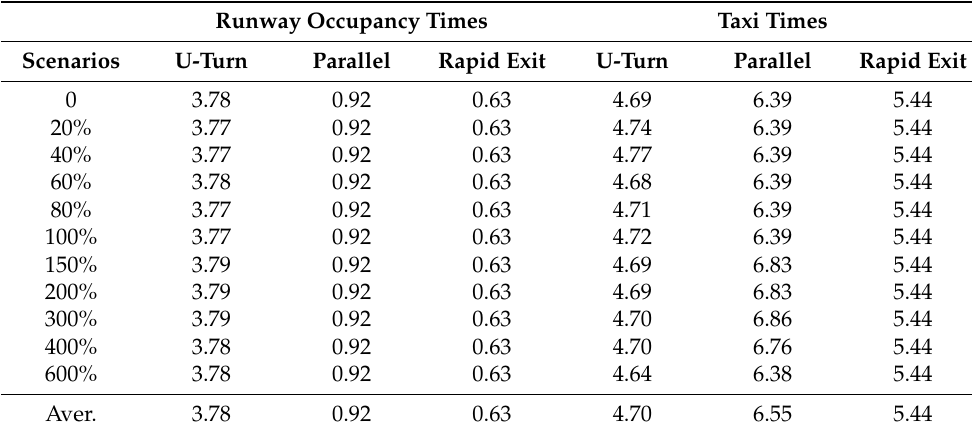
Table 9. Runway occupancy times and taxi times of arrivals (minutes).